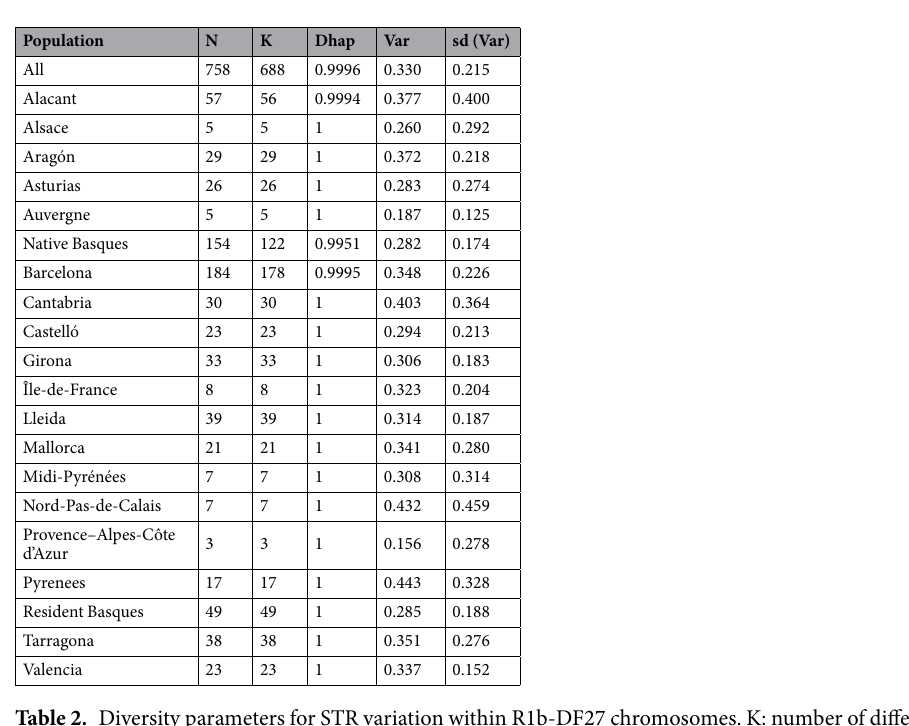
Figure 3. Principal component analysis of subhaplogroup frequencies. Population abbreviations as in Table 1. Circles: Iberian populations; squares: non-Iberian populations.